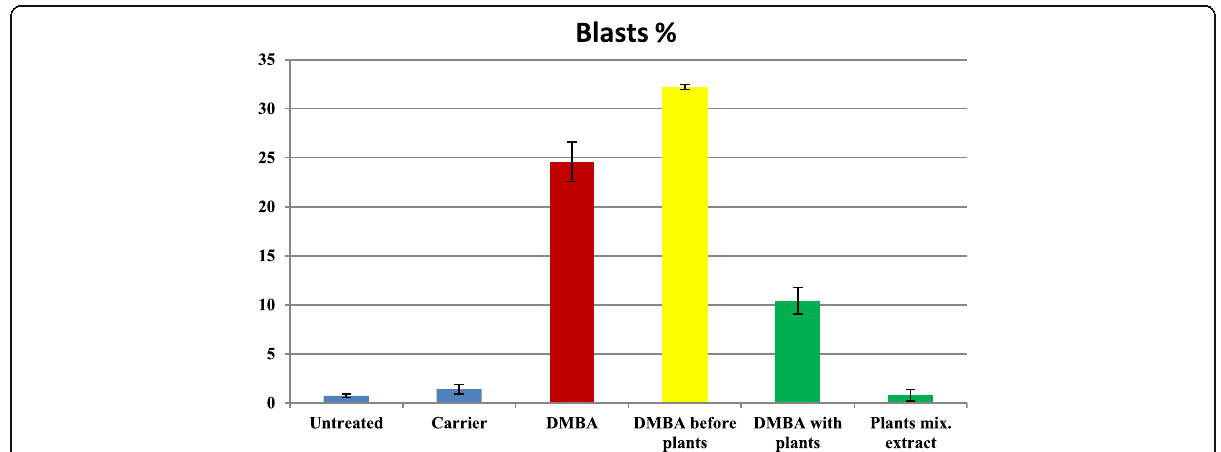
Fig. 5 Blast percentage in the different rat groups. Standard errors are indicated on the bars and the significance levels are shown in Table